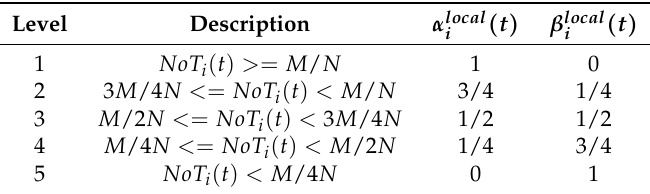
Table 1. The relationship between Num i ( t ) and local